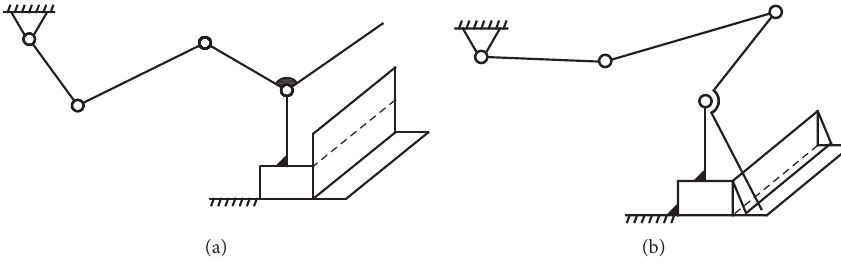
Figure 10: The planar double-folded metamorphic mechanism. (a) Configuration 1. (b) Configuration 2.